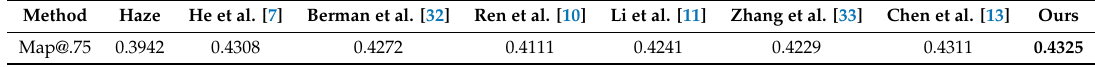
Table 3. The detection results of railway hazy images and dehazing images.